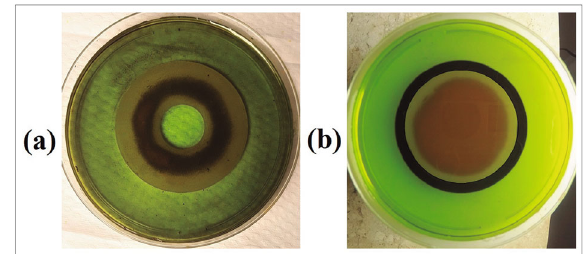
Fig. 3 The edge effect. a Picture of the CCL disc with a 16-mm hole in the center after the corrosion experiment. b Picture of the CCL disc corrosion with the ink-protected perimeter.